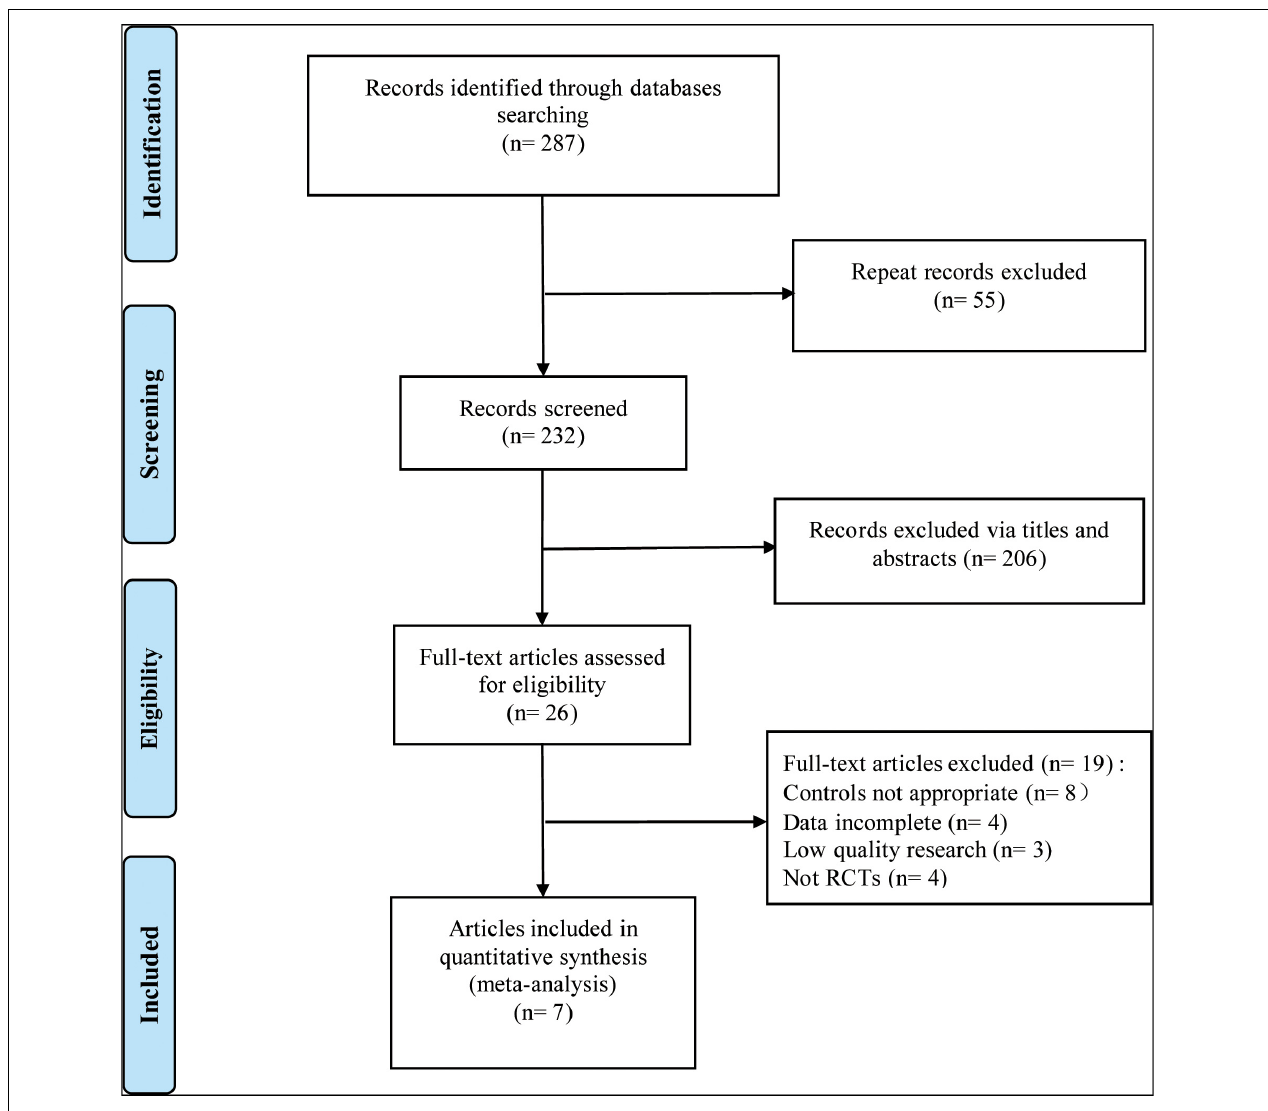
FIGURE 1 | Flow diagram of literature retrieval.